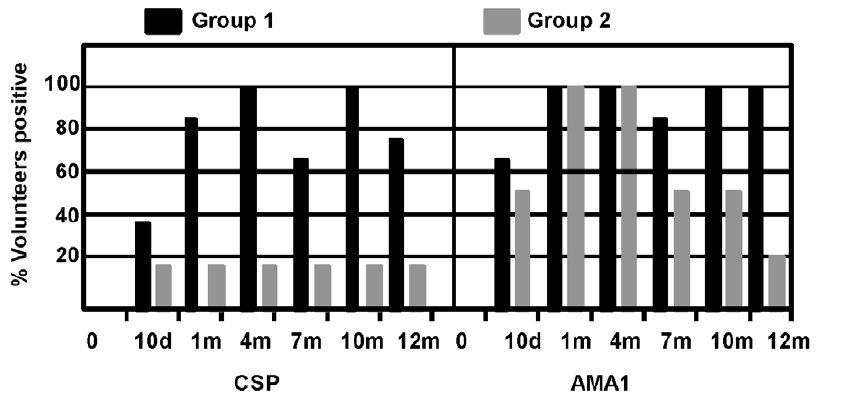
Figure 5. Percent of Group 1 and Group 2 volunteers who responded to one or more CSP or AMA1 peptide pools at each time point after immunization. ELISpot activity was determined to be positive or negative for a given peptide pool as described in Methods. A positive volunteer is one who recognized one or more peptide pools at each of the time points 10 d and 1, 4, 7, 10 and 11–12 m after immunization. The percent positive responders are displayed at each time point for CSP or AMA1.